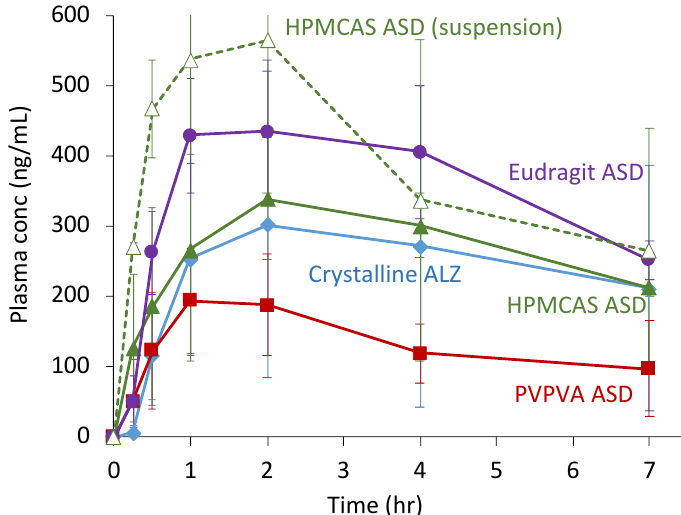
Figure 7. Plasma ALZ sulfoxide concentration profiles after oral administration of crystalline ALZ and its ASDs in beagle dogs at a dose of 10 mg/kg ( n = 3). Formulations were administered as capsules unless otherwise noted as suspension. Symbols: crystalline ALZ ( ◆ ), PVPVA ASD ( ■ ), HPMCAS ASD ( ▲ ), HPMCAS ASD (suspension) ( △ ), Eudragit ASD ( ● ). Table 4. PK parameters for oral administration study of ALZ ASDs in beagle dogs.